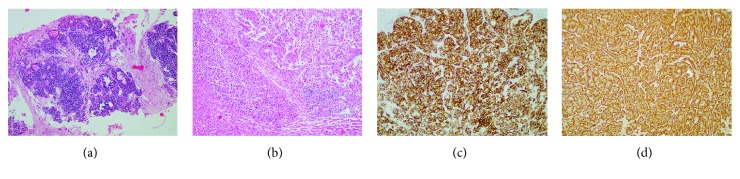
Immunohistochemistry of hepatic neuroendocrine carcinomas. (a) Histological examination showed crowded cells in the liver, striking karyokinesis, and a significantly increased karyoplasmic ratio (×100). (b) Histological examination showed atypical carcinoma cells, partially low regional differentiation, and significantly increased mitoses close to the surrounding liver invasion (×100) caused by the karyoplasmic ratio. (c) Immunohistochemistry revealed that the tumor cells were positive for Syn (×100). (d) Immunohistochemistry revealed that the tumor cells were positive for CgA (×100).